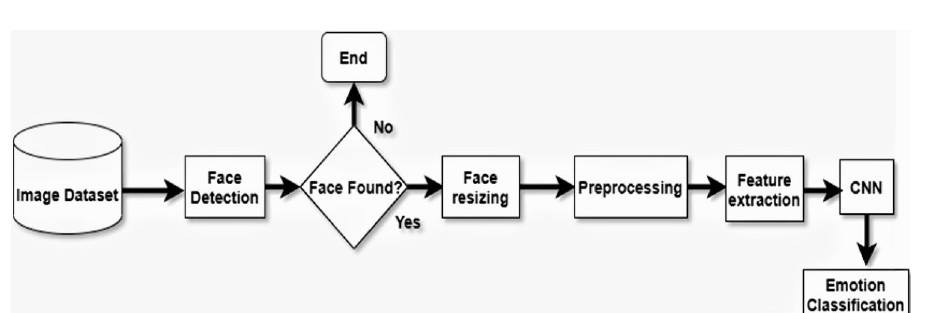
Figure 10. The examples of seven basic emotions for the validation purpose. . (Figure adapted from our own test images 39 )